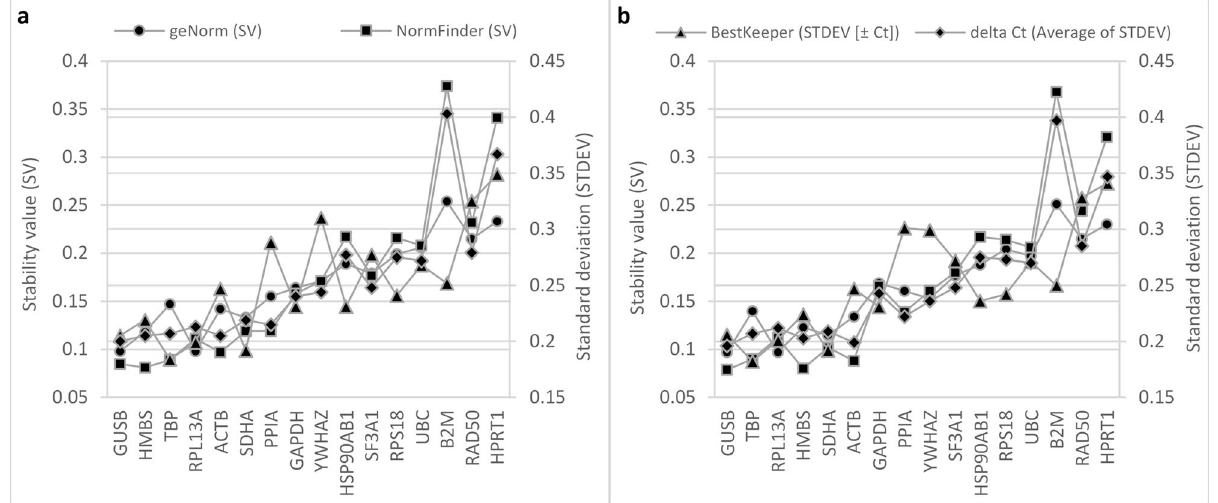
Figure 3. RefFinder candidate RG output. RefFinder results using ( a ) median, and ( b ) mean Ct values of technical replicates. Genes showing the highest stability, as determined by RefFinder’s comprehensive ranking, are ordered left to right on the x-axis. Individual results from embedded algorithms (geNorm, NormFinder, BestKeeper, and delta Ct) are also illustrated. Lower stability values (SV) and standard deviation (STDEV) are indicative of more stably expressed genes. Sixteen candidate RGs were assessed across n = 7 cell lines, which were reverse transcribed in triplicate and combined, and consequently assayed in technical triplicates. Data represent one independent